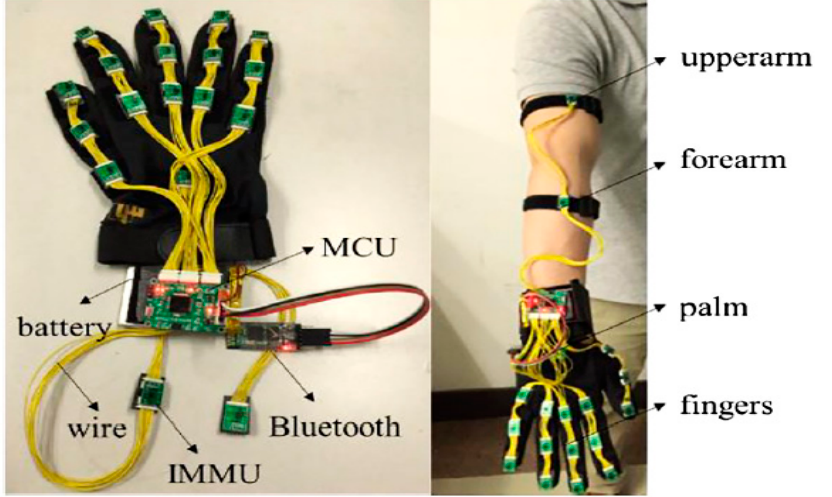
Figure 14. The designed sensory glove with highlighted the main components ( left ) and worn by a user ( right ) [110].